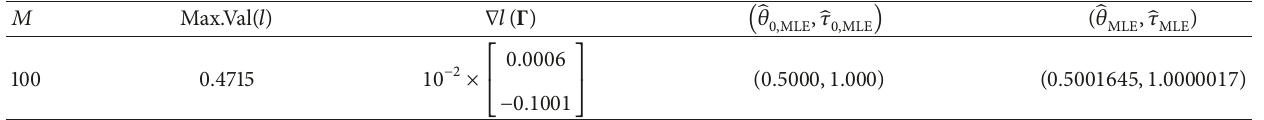
Table 2: Table showing value of Max.Val (𝑙) , ∇𝑙( Γ ) , and (